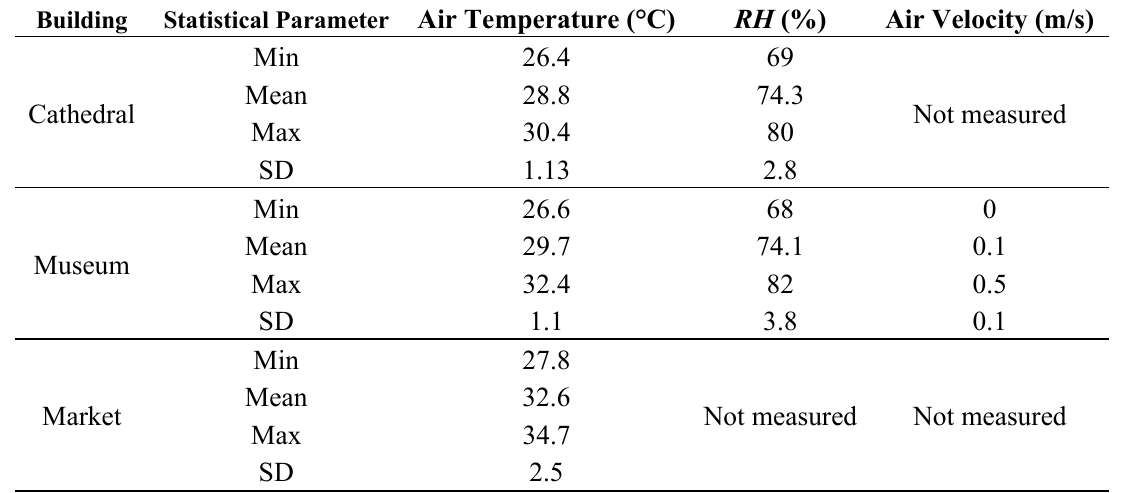
Table 2. Data of indoor climatic parameters and thermal sensation vote ( TSV ).